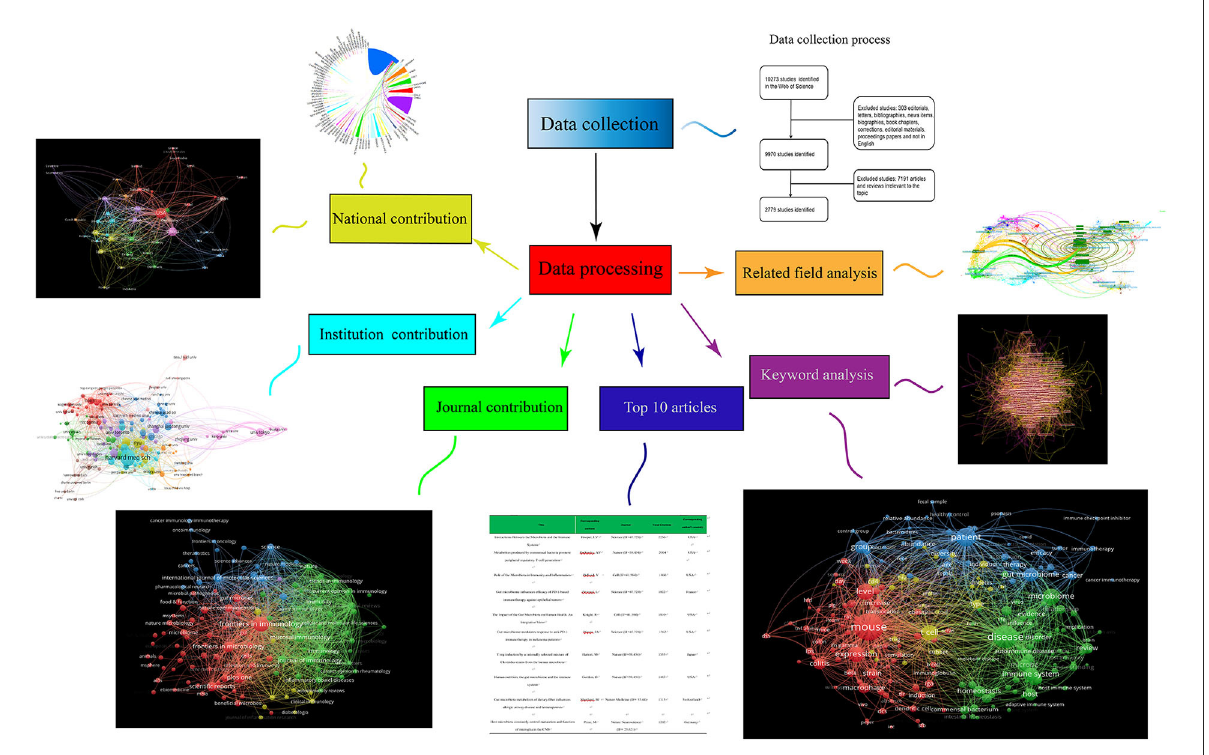
FIGURE2 Flow diagram of six aspects of gut microbiota and host immune response. Contributions of countries, contributions of different journals, the top 10 articles, contributions of different institutions, keywords and related